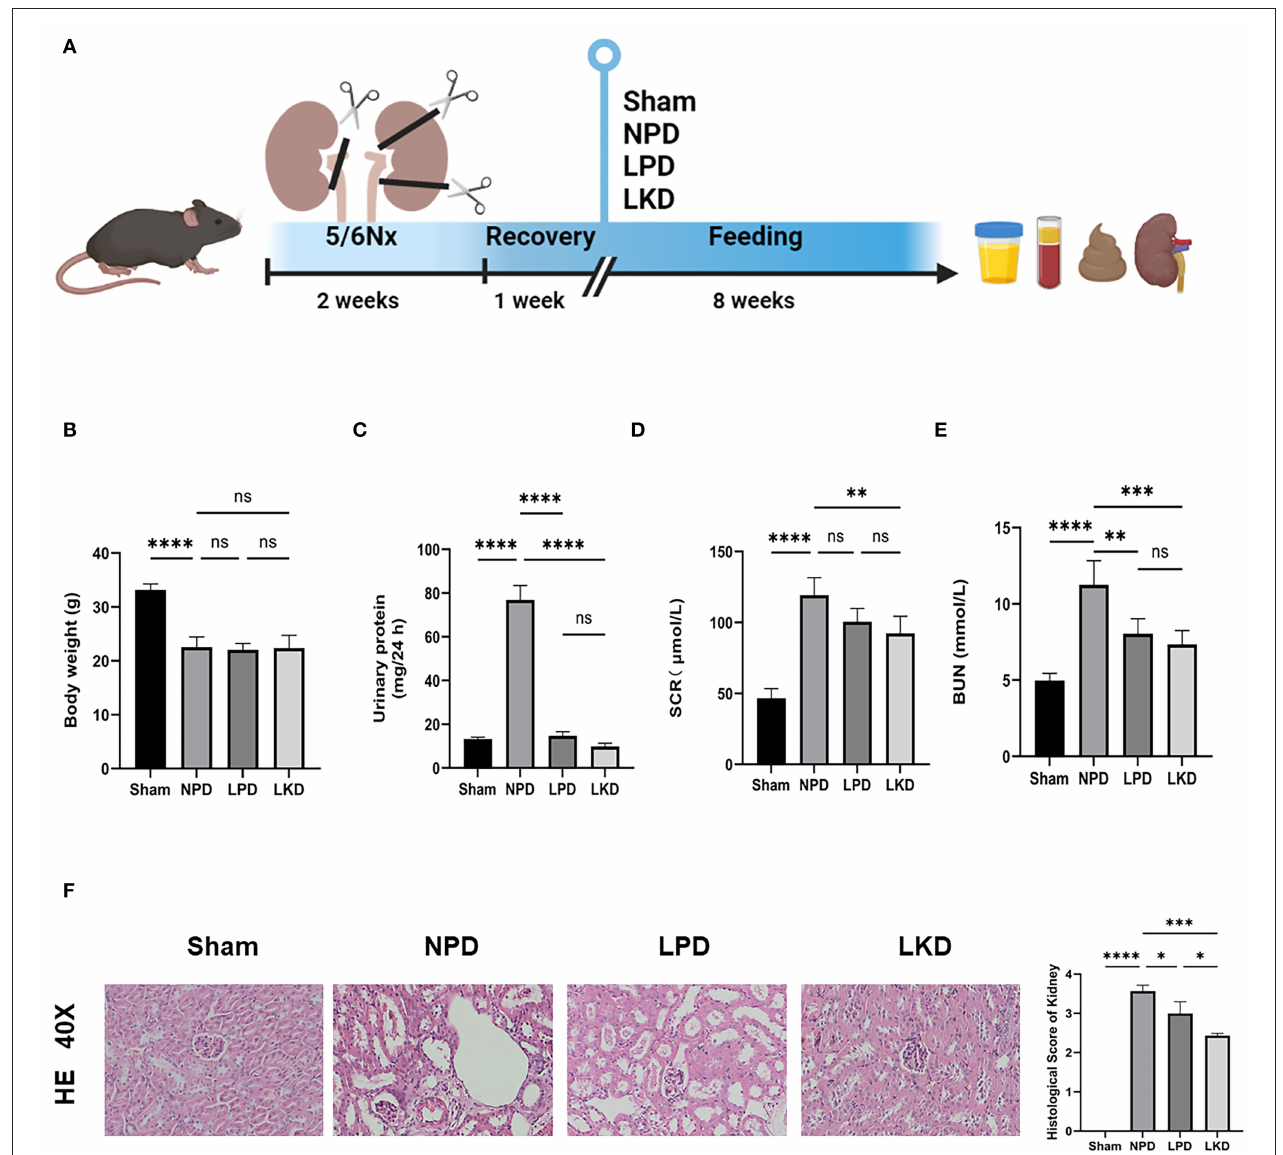
FIGURE 1 | Flowchart, analysis of renal function, and kidney H&E staining. (A) The flowchart of the animal experiment. Mice were randomly divided into three groups after 5/6Nx and fed with different weight of protein. (B) Comparison of the body weight after 8-week feeding (ANOVA test). (C) Comparison of the urinary protein (24h) (ANOVA test). (D) Comparison of the serum level of creatinine (ANOVA test). (E) Comparison of the level of blood urea nitrogen (ANOVA test). (F) Representative images (40 × ) for H&E staining of kidney tissues and score of renal injury (ANOVA test). Ns, not significant; * p < 0.05; ** p < 0.01; *** p < 0.001; **** p <